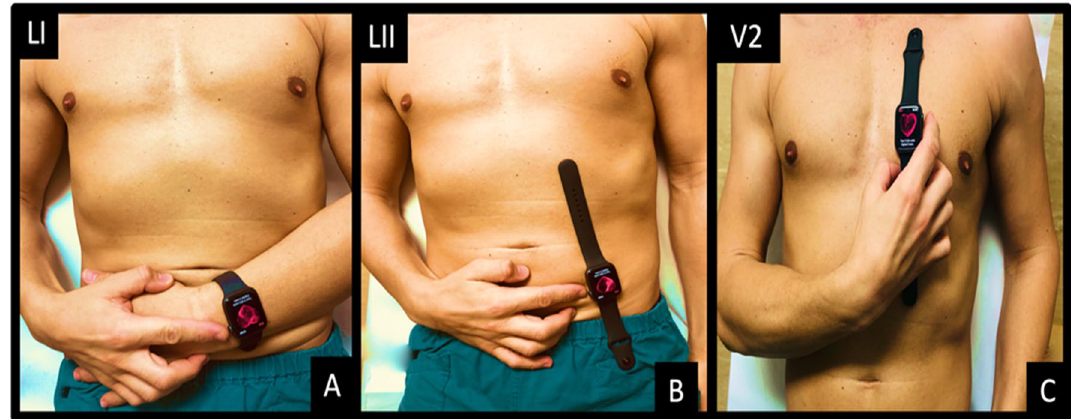
Figure 1. Method used to collect lead I, lead II, and the V2 lead with the smartwatch. Lead I was recorded with the smartwatch on the left wrist and the right index finger on the crown ( A ). Lead II was obtained with the smartwatch on the left lower abdomen and the right index finger on the crown ( B ). Chest lead V2 was recorded with smartwatch in the fourth intercostal space left parasternal with the right index finger on the crown ( C Lead I (I) was recorded with the smartwatch on the left wrist and right index finger on the crown (Fig. 1A). Lead II (II) was obtained with the smartwatch on the left lower abdomen and right index finger on the crown (Fig. 1B). Chest lead V2 was recorded with the smartwatch in the fourth intercostal space left parasternal with the right index finger on the crown (Fig. 1C). All recorded 30’s ECGs were digitally stored using the health application of iPhone Series 10 in pdf format. The measurements of the QT interval were made on the printout of the ECG in pdf format. The advantage of saving ECGs in pdf format is that it can be sent also via e-mail. Standard ECG acquisition. The standard 12-lead ECGs were performed using commercially available electro- cardiography (PHILIPS, 3000 Minuteman Road Andover; MA 01810, USA) with a paper speed of 25 mm/s. QT interval measurements. The QT interval was measured from the beginning of the QRS complex to the end of the T-wave, as an average of three beats. Additionally, to minimize the error in detecting the true end of the T wave and the correct QT interval we used a tangent drawn to the steepest last limb of the presumed T-wave to define the end of the T-wave as the intersection of this tangent with the baseline 7 . Also, in the case of the presence of U wave, we not included it in the measurement of QT interval because there are no accepted reference values for the QU interval, and often dedicated electrocardiographic techniques are needed before one can focus on the U-wave 7 . Additionally, in the case of bundle branch block, we measured from the beginning of the QRS complex to the end of the T wave, using the same calculation method used in the absence of bundle branch block. Adjusting the QT interval for heart rate (QTc) was done according to Bazett’s formula (QTcB). QTcB = QT/